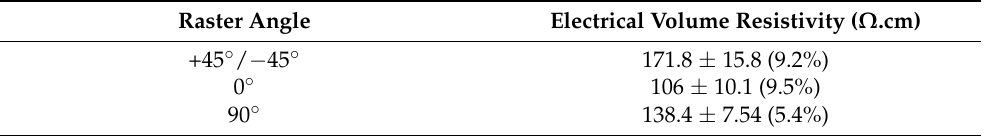
Figure 16. The electrical circuit connected using the 3D-printed PLA/PCL/25 wt.% M5 composite. The electrical volume resistivity results of the PLA/PCL/20 wt.% M5 composites printed according to the diagonal pattern (alternating raster angle of +45 ◦ / − 45 ◦ ) (Figure 1a), the longitudinal pattern (raster angle of 0 ◦ ) (Figure 1b), and the transversal pattern (raster angle of 90 ◦ ) (Figure 1c) are shown in Table 7. Table 7. The electrical volume resistivity results of the PLA/PCL/20 wt.% M5 composites according to three different patterns by changing the printing raster